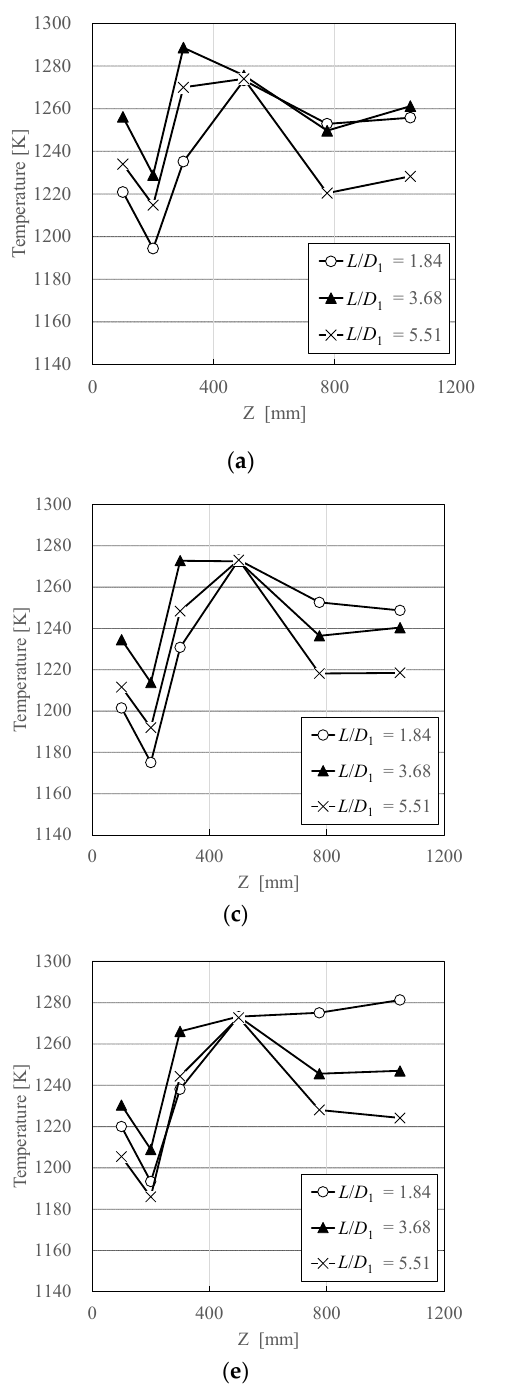
Figure 10. Comparison of temperature distribution for different L / D 1 at (a) E NH3 = 10%; (b) E NH3 = 40%; (c) E NH3 = 60%; (d) E NH3 = 80% (e) E NH3 = 100%. Input = 11.63 kW, λ total = 1.2, D 2 / D 1 = 0.24.